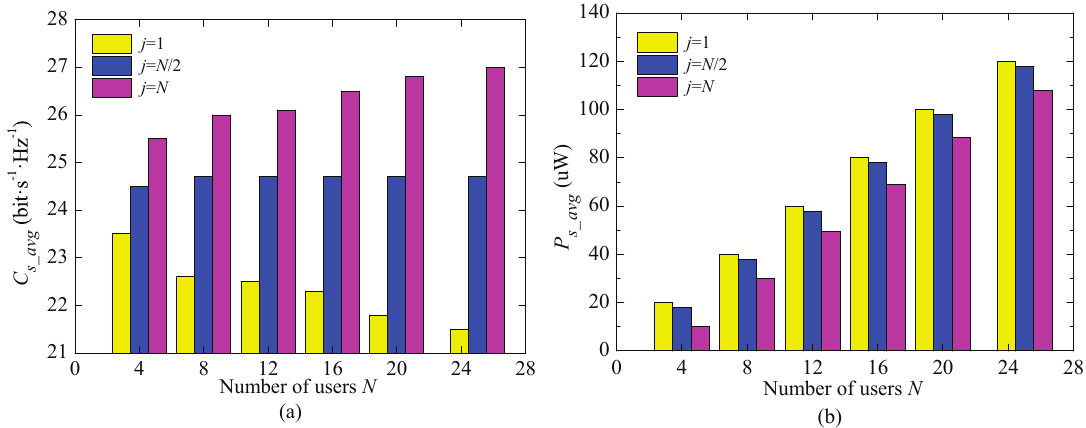
Figure 6. The average system capacity and total collected energy of INS2M with different numbers of users within the independent identically distributed Weibull fading channels, k = 1.5. ( a ) the average system capacity; ( b ) the total collected